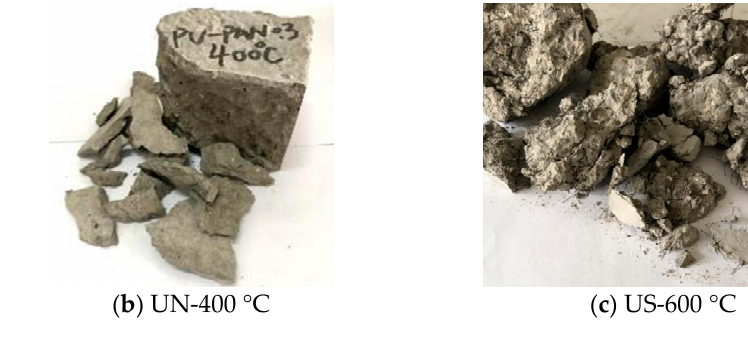
Figure 4. The bursting specimens after exposure to high temperatures.